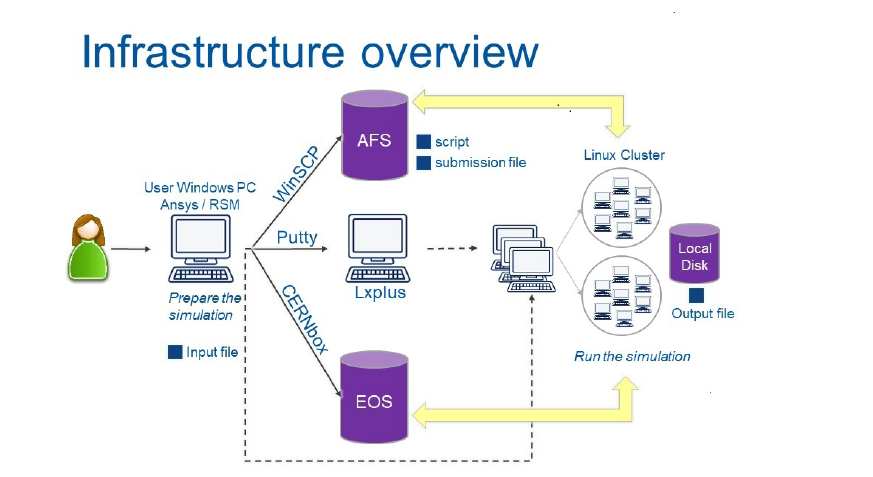
Figure 4. Linux HPC cluster